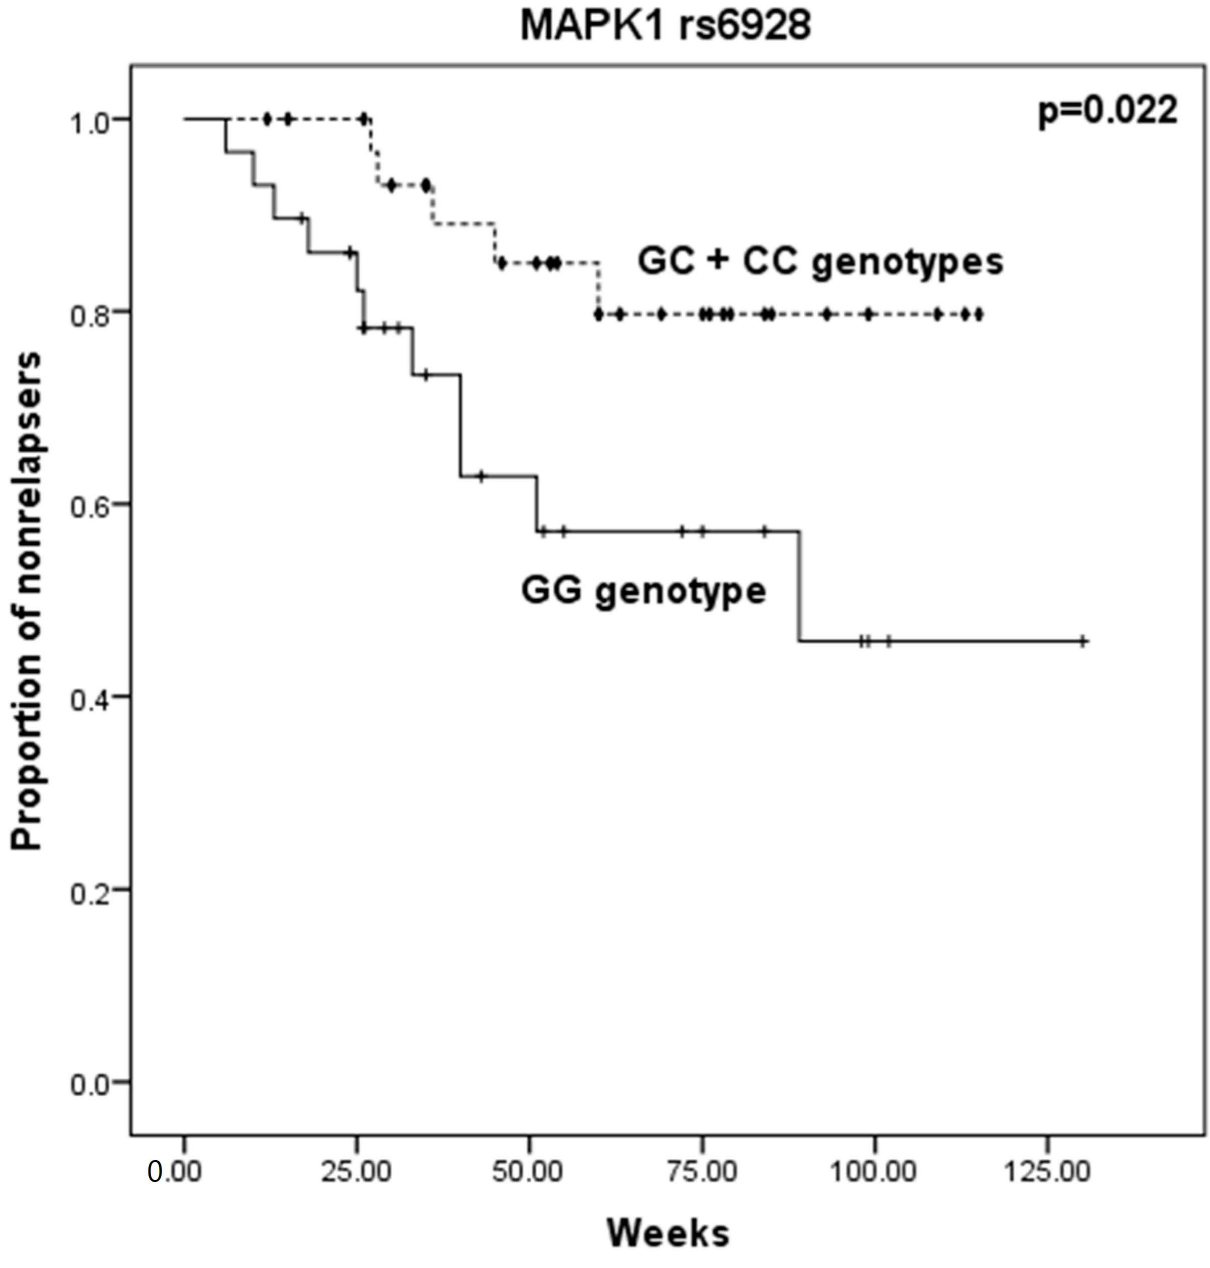
Figure 1. Effect of MAPK1 rs6928 genotypes in time to relapse in MDD patients. Kaplan–Meier analysis was used to evaluate the association between time to relapse and MAPK1 rs6928 GG and GC + CC carriers. Comparison performed by Log-rank test ( p =